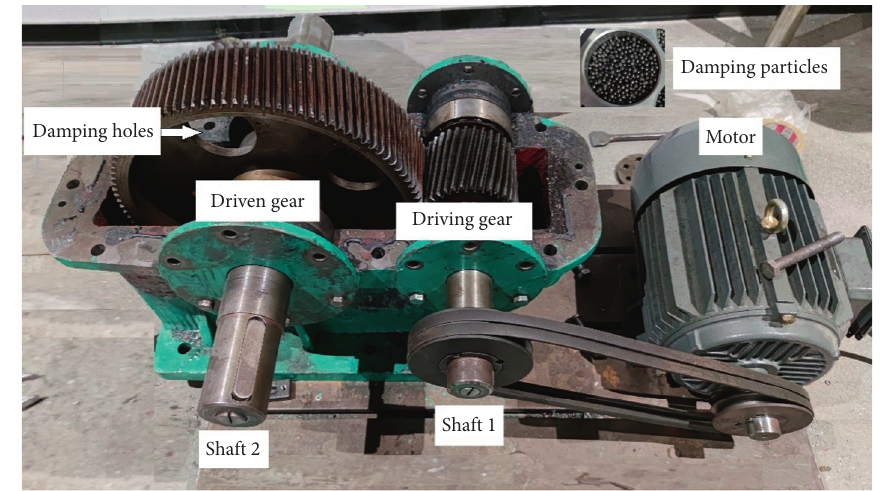
Figure 14: Experimental rig